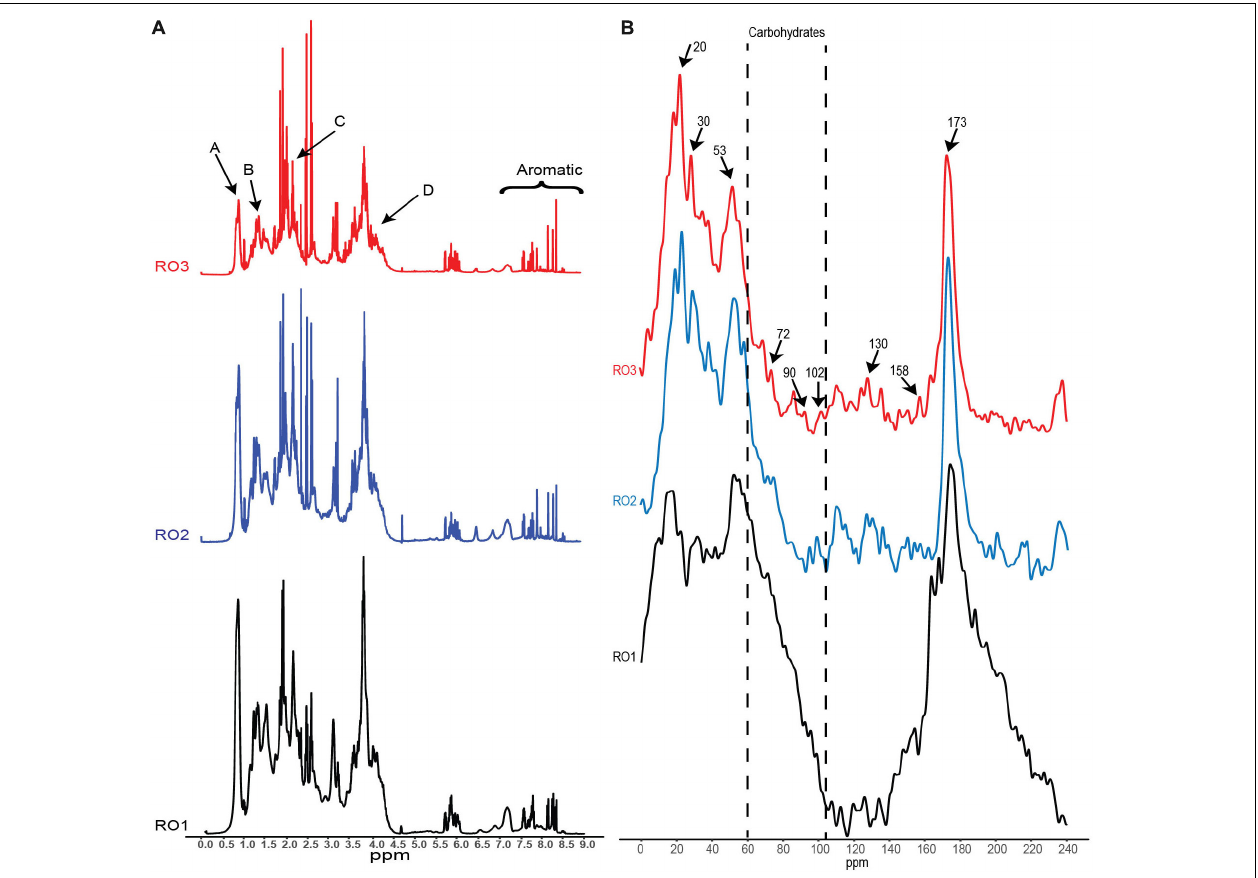
FIGURE 4 | NMR analysis of the EPS. (A) 1 H NMR spectra showing peaks (A, B, C, D) corresponding to different functional groups associated with specific chemical compounds. (B) Solid-state 13 C NMR spectra revealing chemical structures in the EPS. Arrows indicate the chemical shifts that were identified based on (Khan et al., 2014). Y-axis (not shown) represents signal intensity in arbitrary units.